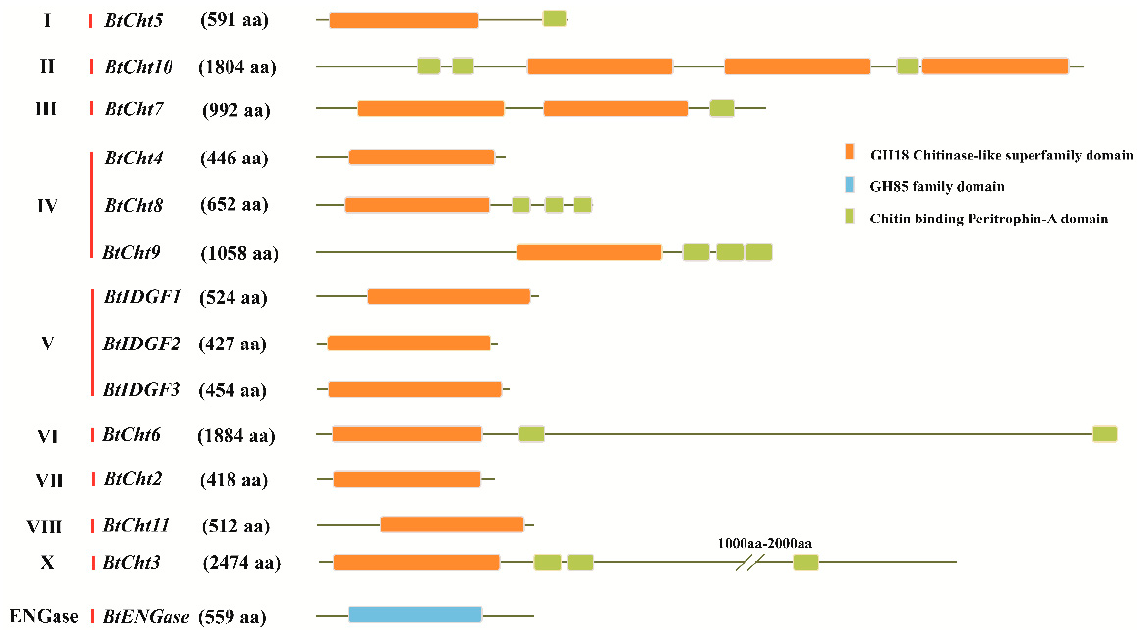
Figure 2. Conserved domain architectures of 14 chitinase-like genes in Bemisia tabaci . Based on chitinase-like gene sequences, the deduced amino acid sequences were obtained. These deduced protein sequences of B. tabaci chitinase ( BtCht ) genes were then subjected to SMART software and a conserved domain- searching tool (National Center for Biotechnology Information) for domain architectures predicting. Orange boxes indicates the GH18 chitinase-like superfamily domain, boxes in green stand for Chitin-binding Peritrophin-A domain and GH85 family domain is implied by a light blue box. ENGase, endo- β -N-acetylglucosaminidase; GH, glycoside hydrolase; IDGF, imaginal disk growth